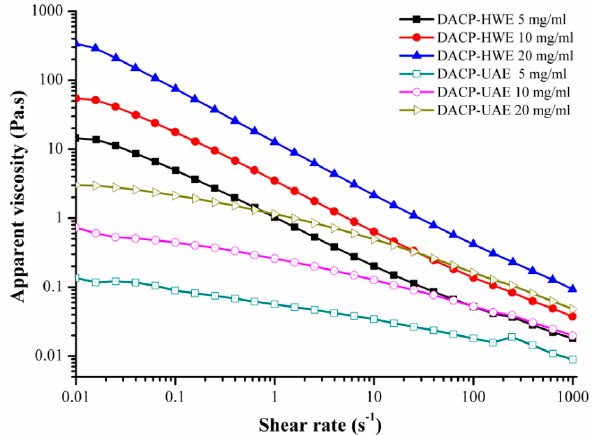
Figure 5. Steady shear flow curves of DACP-HWE and DACP-UAE solutions with different concentrations (5, 10, 20 mg/mL) as a function of shear rate.